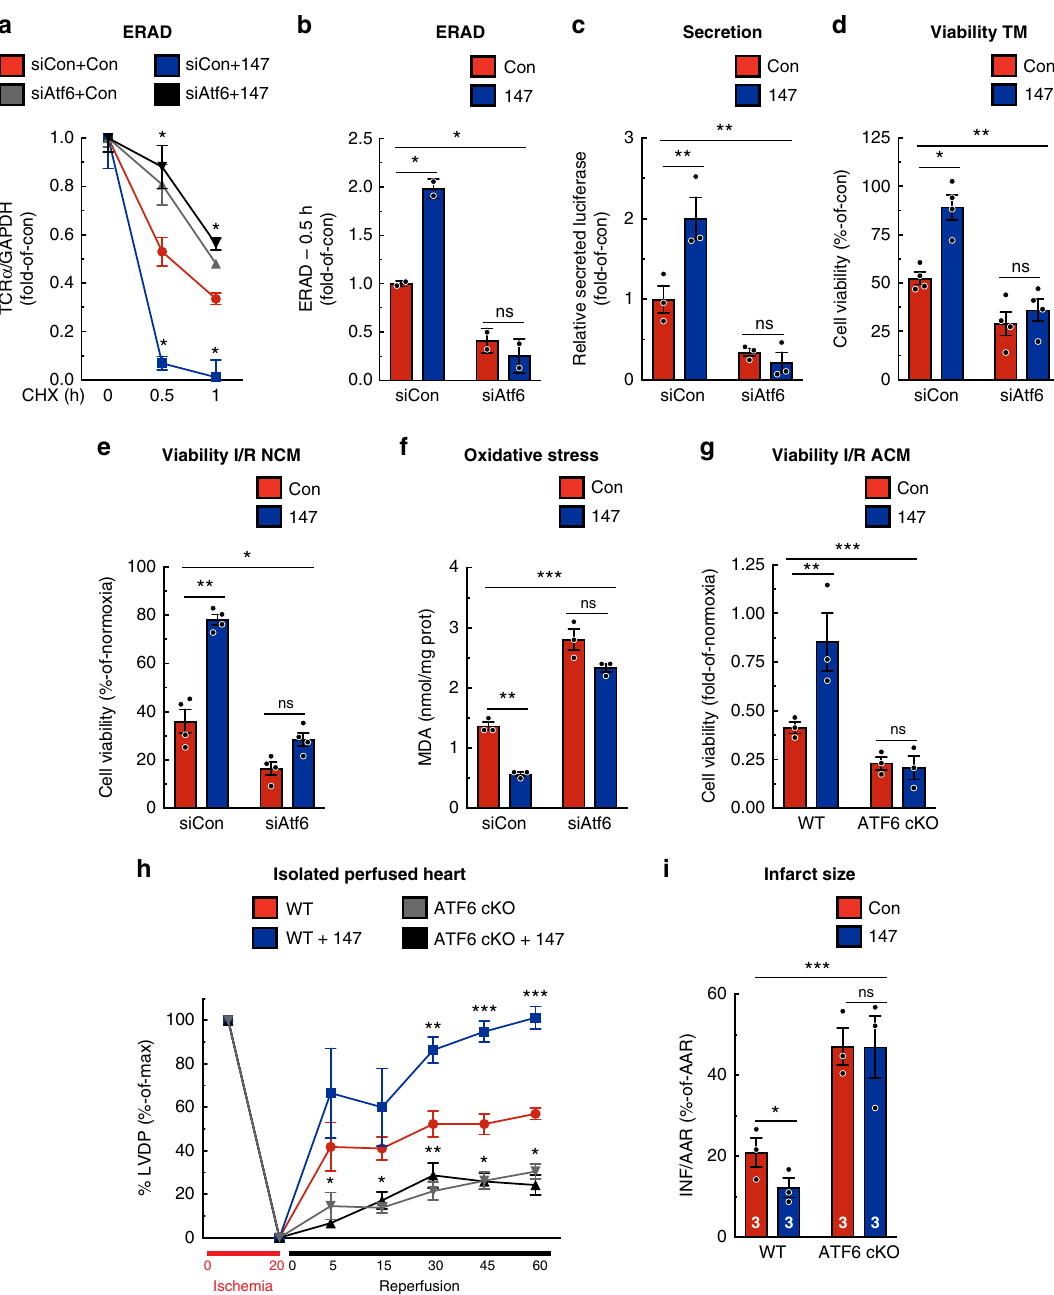
Fig. 4 147 improves proteostasis and decreases oxidative stress in an ATF6-dependent manner. a , b NRVM were infected with AdV-HA-T cell antigen receptor α -chain (TCR α ; an ER-transmembrane protein that is chronically misfolded and degraded by ERAD), treated with siCon or siAtf6 and either control or 147 for 24 h prior to cyclohexamide for 0, 0.5, or 1 h. Densitometry of the HA-TCR α immunoblots at the respective times ( a ) and ERAD at the 0.5-h time point ( b ) are shown ( n = 2). c Secretory proteostasis assayed in NRVMs when transfected with Gaussia luciferase and treated with siCon or siAtf6, and either control or 147 for 24 hours. Medium was collected and luciferase activity was measured ( n = 3). d NRVMs were transfected with siCon or siAtf6, and then treated with or without TM, control or 147 for 24 hours, after which viability was determined ( n = 4). e , f NRVMs were transfected with siCon or siAtf6, treated with or without control or 147 for 24 hours, and then I/R, after which viability ( e ) and malondialdehyde (MDA) ( f ) were measured. g Viability of I/R-treated cultured adult cardiomyocytes isolated from WT ( n = 3) or ATF6 cKO ( n = 3) mice 24 hours post treatment with control or 147 . h , i LVDP ( h ) and relative infarct sizes ( i ) of WT or ATF6 cKO mice treated 24 hours with control or 147 and then ex vivo I/R. Data are represented as mean ± s.e.m. Two-group comparisons were performed using Student ’ s two-tailed t test, and all multiple group comparisons were performed using a one- way ANOVA with a Newman – Keuls post hoc analysis. ** P ≤ 0.01 and *** P ≤ 0.001; ns not signi fi cant